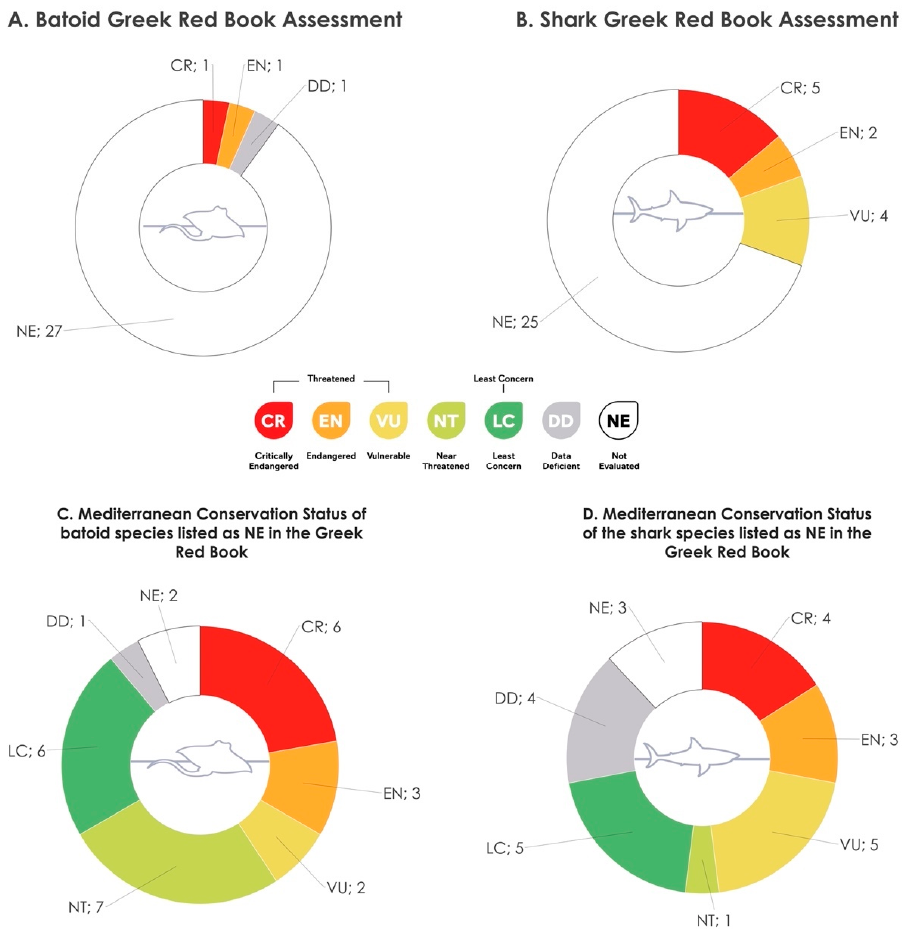
Figure 3. ( A , B ). Conservation status of the batoid and shark species, respectively, present in Greek waters, assessed in the Greek Red Book. ( C , D ). IUCN Conservation status of the Mediterranean population of the batoid and shark species, respectively, present but not evaluated in the Greek waters.